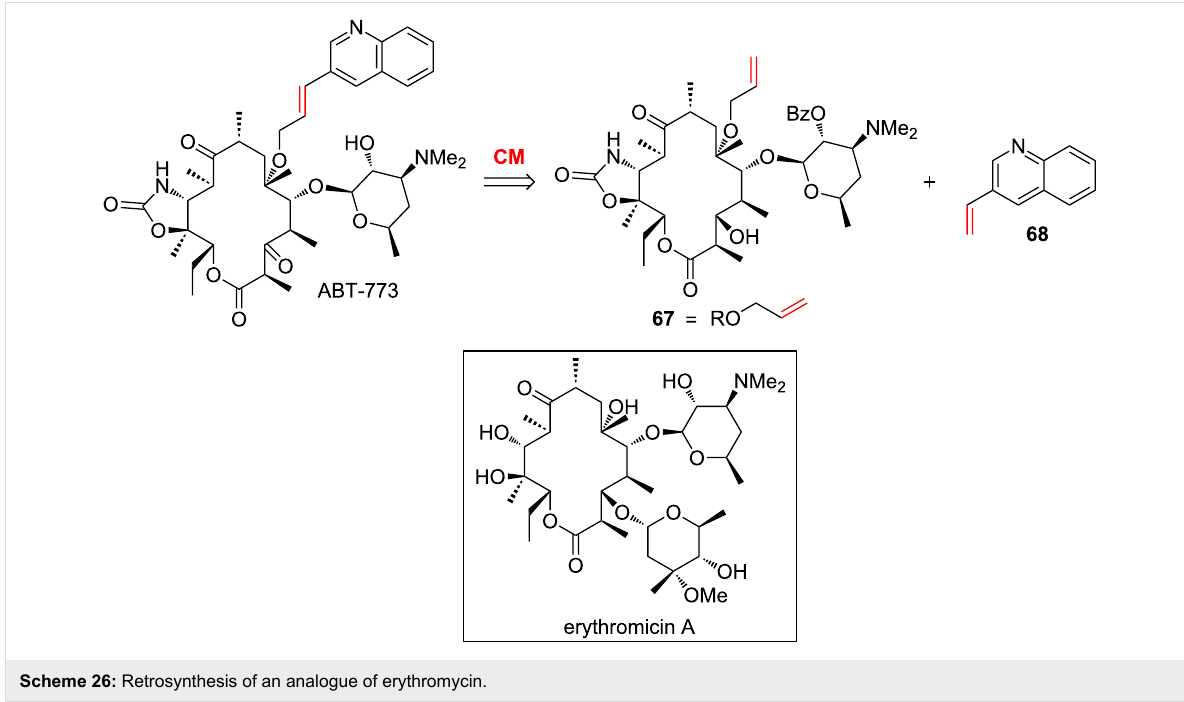
Table 4: CM between vinylquinoline and an O -allyl-protected erythronolide derivative.